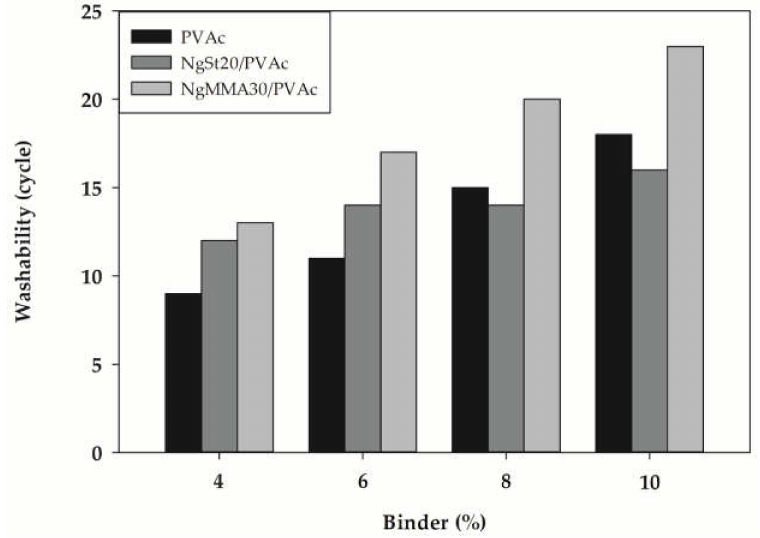
Figure 4. Washability Combination of NRL grafting Styrene or MMA and